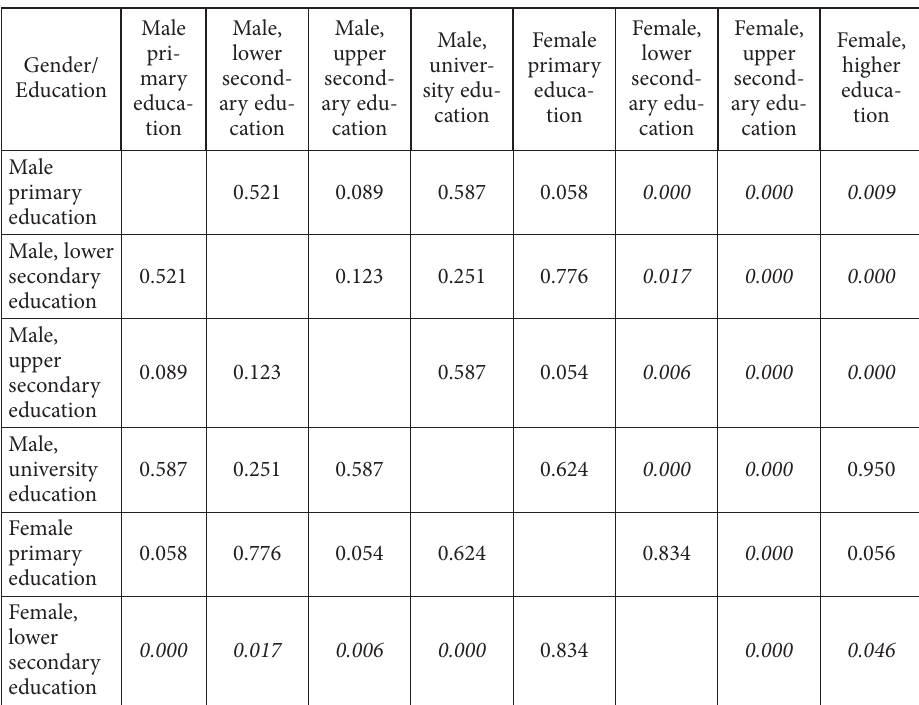
Table 11. Tukey’s HSD test results within motivational factors for good working